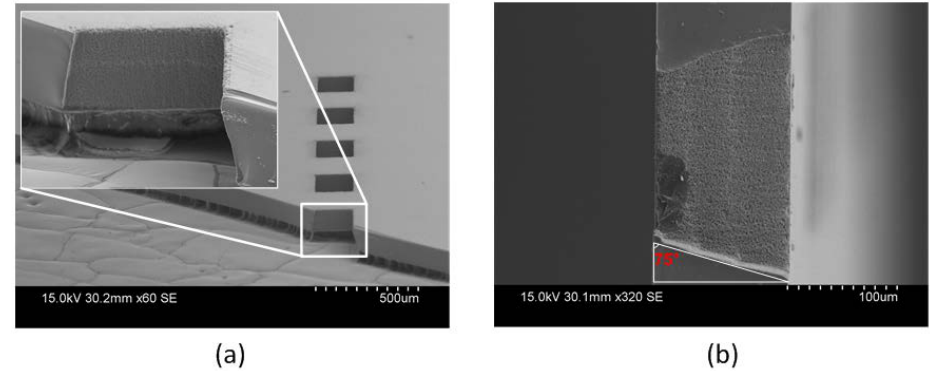
Figure 5. ( a ) SEM micrograph of laser etched via holes; ( b ) Cross-section image, etching direction from right to left.